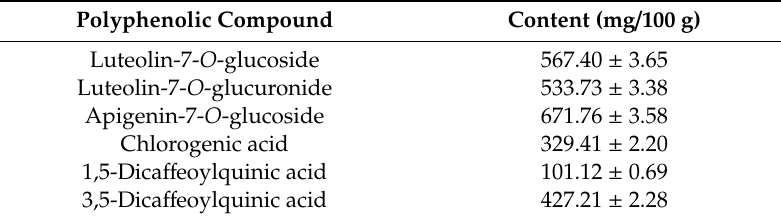
Table 2. Polyphenolic compounds identified in HCF.